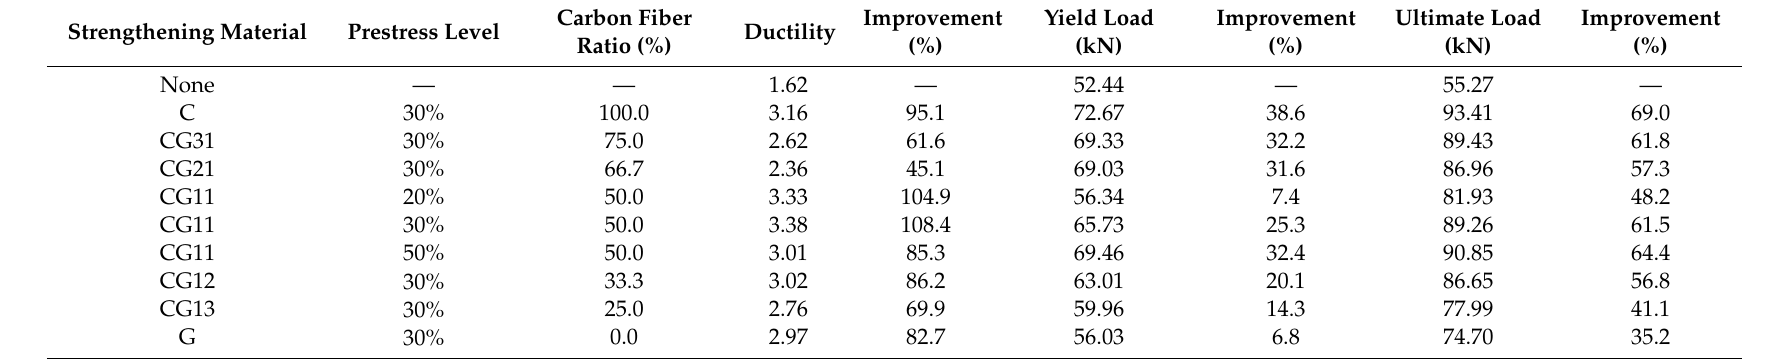
Table 7. Flexural capacity of the